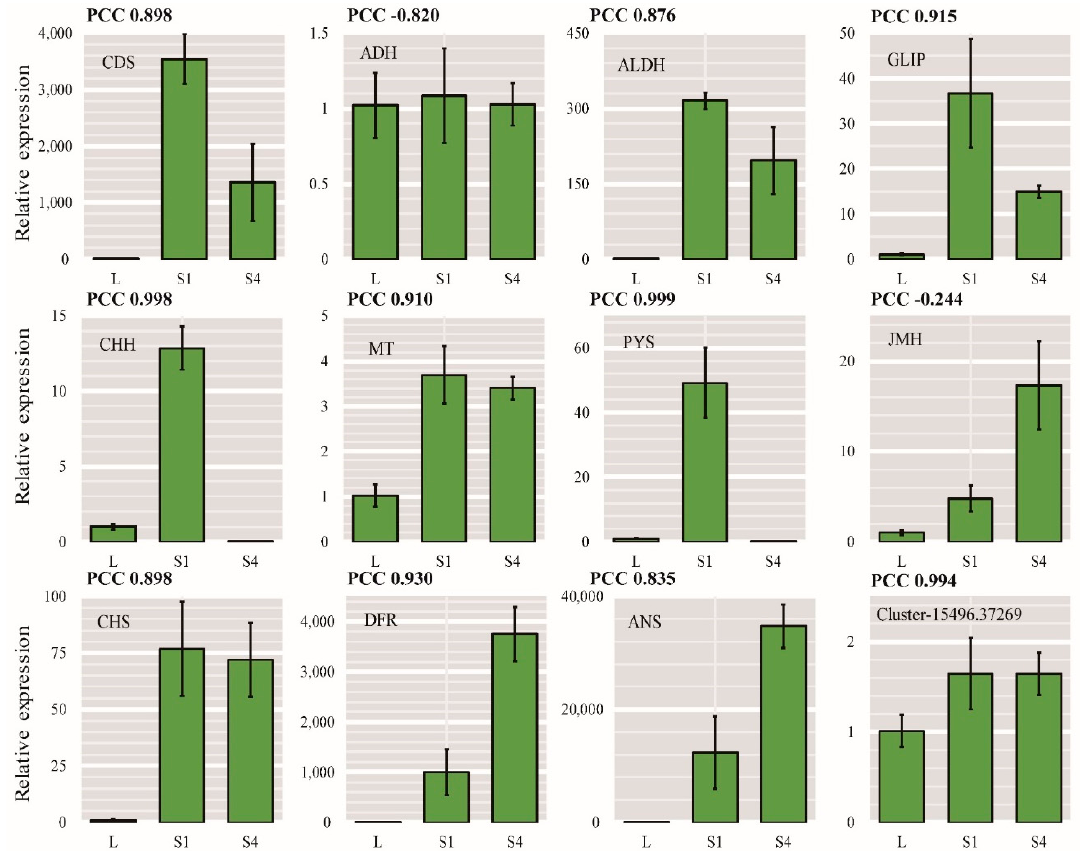
Figure 6. qRT-PCR validation of the genes related to the biosynthesis of pyrethrins and anthocyanin. Values are represented as averages ± standard deviations from three biological replicate samples. The PCC values (Pearson correlation coefficients) for the relative expression according to qRT-PCR compared with log 2 (FPKM+1) for RNA-Seq are indicated at the top of each graph.